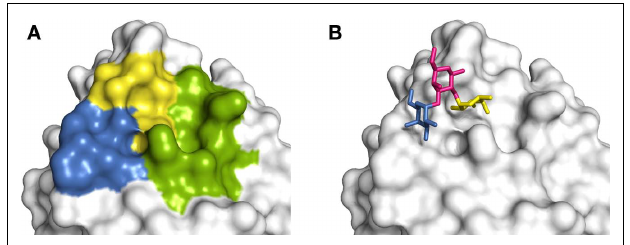
FIGURE 2 | Carbohydrate-binding subsites of langerin. (A) Langerin has three discernable subsites within its binding site, two of which are demonstrated to be involved in carbohydrate recognition. Color guide: blue – α -galactose-binding subsite, yellow – α -fucose-binding subsite, green – potential additional binding site. (B) Langerin in complex with blood group B antigen (Gal α (1 → 3)[Fuc α (1 → 2)]Gal β ). Color guide: blue – α -galactose, yellow – α -fucose, pink – β -galactose. Figures generated in PyMOL using the langerin-B antigen complex structure (PDB code 3P5H).